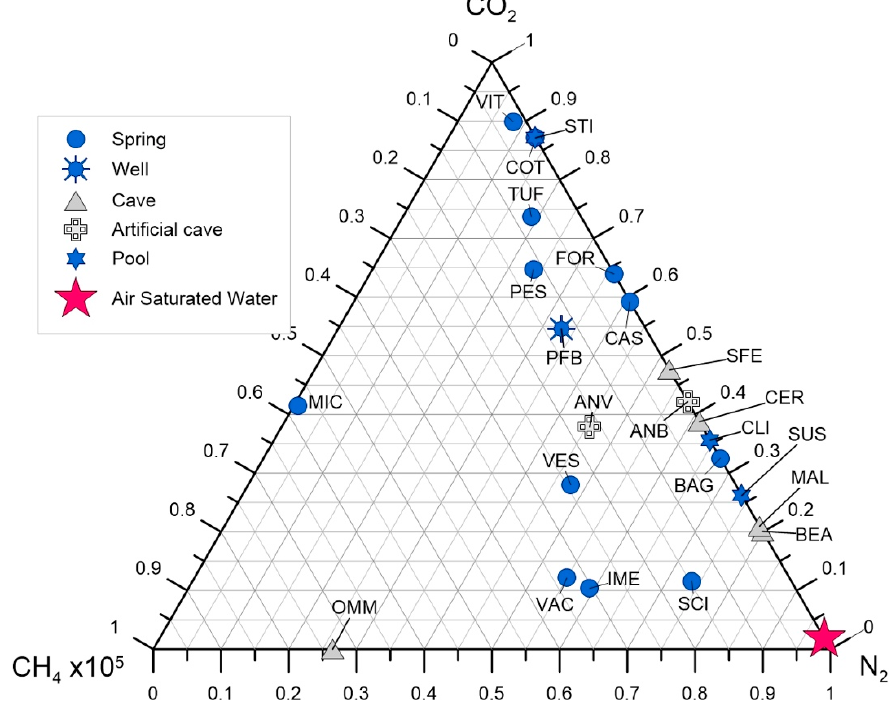
Figure 6. Ternary diagram showing the relative abundances of dissolved N 2 , CO 2 and CH 4 × 10 5 determined in the sampled waters.